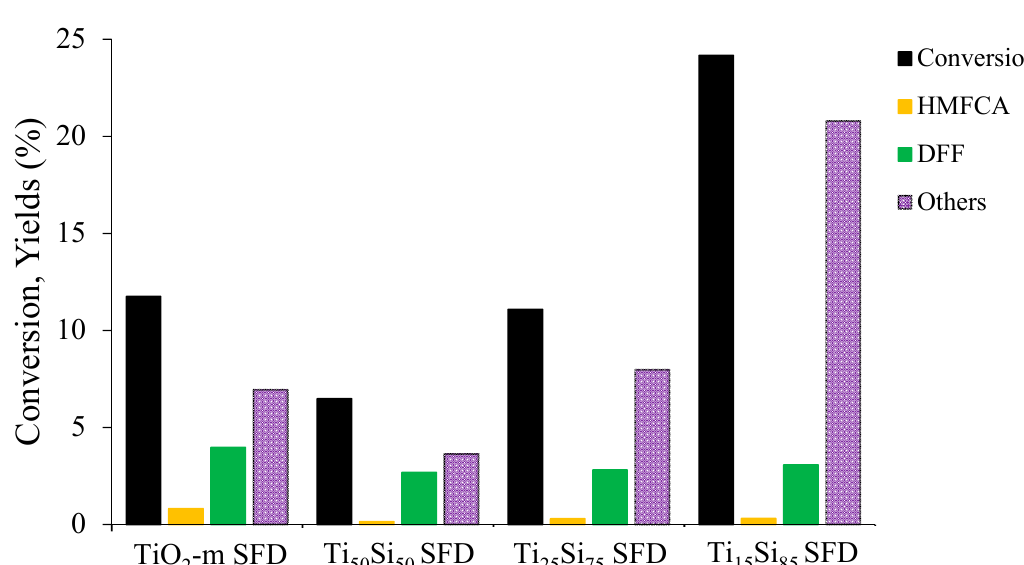
Figure 7. Photocatalytic performances of titania-silica spray-freeze-dried nanocomposites at different compositions. Reaction conditions: t = 1 h, T = 30 °C, P = 1 atm O 2 , m cat = 20 mg, V = 20 mL, [HMF] 0 = 5 × 10 − 4 mol/L.